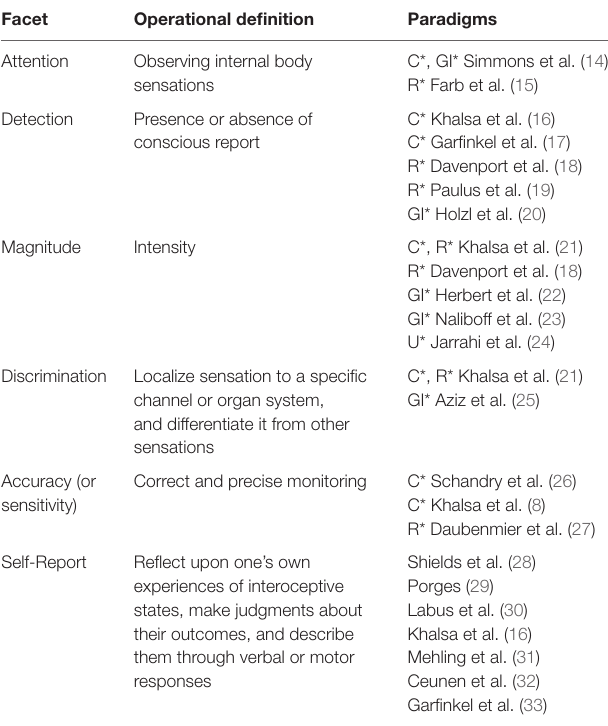
TABLe 2 | Facets of interoception.